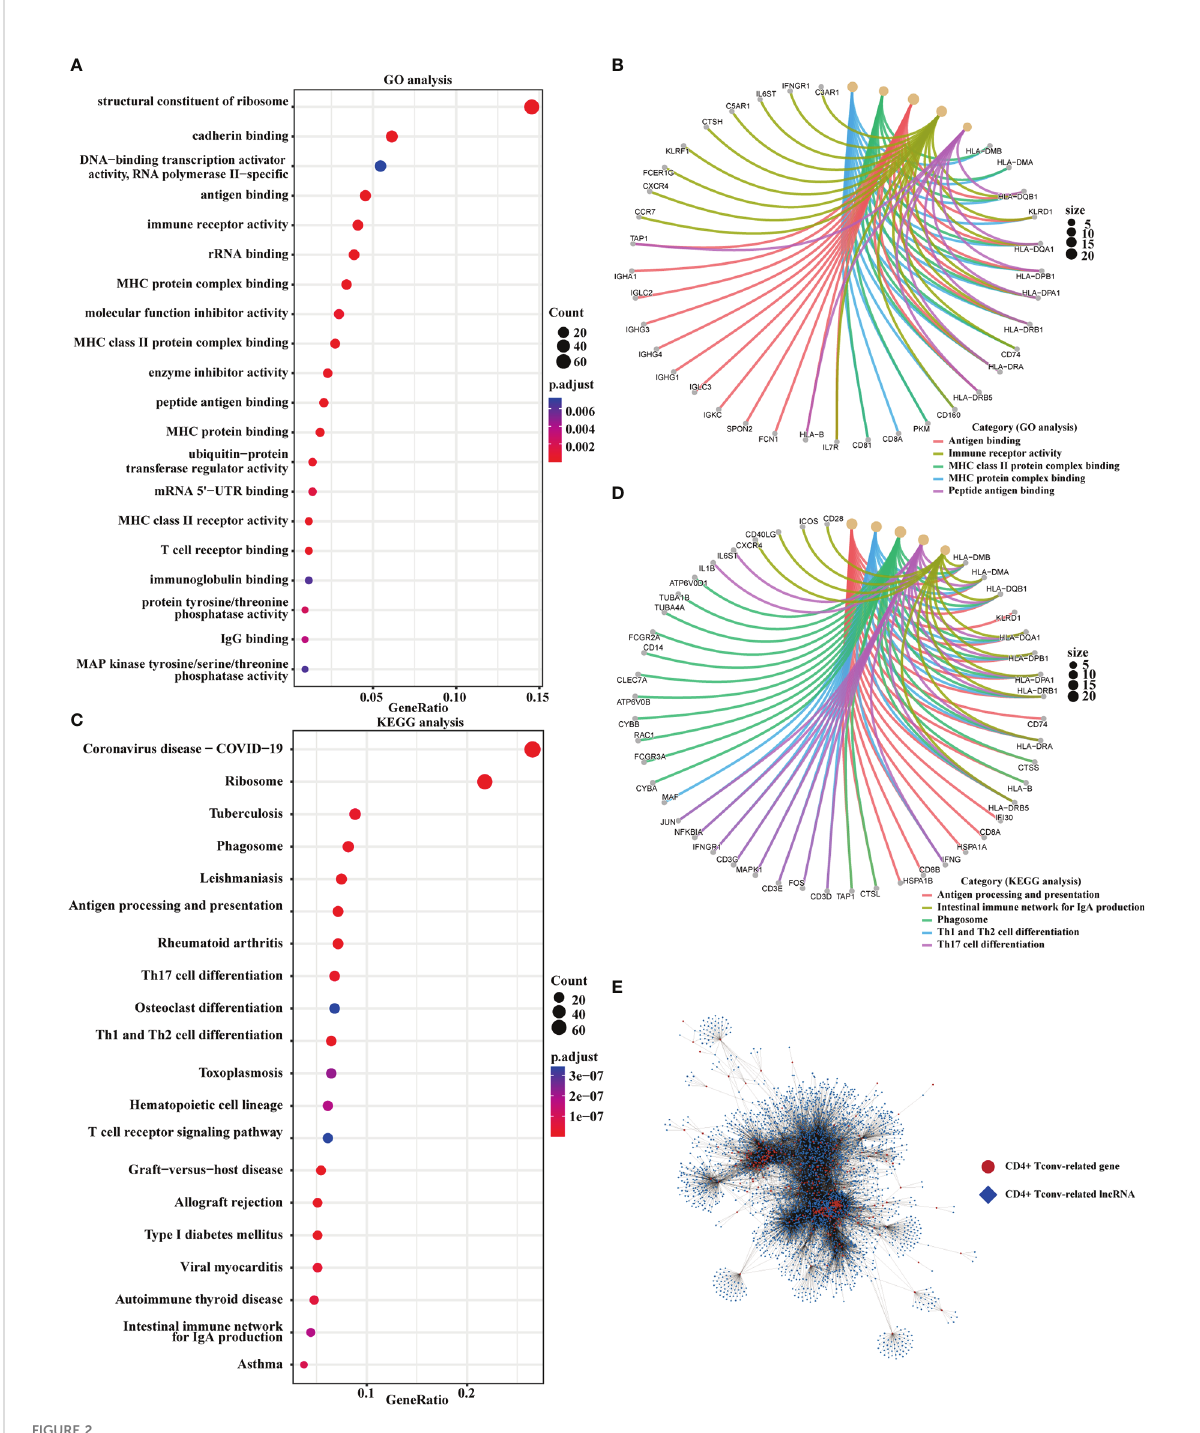
FIGURE 2 Functional enrichment and the co-expression network of CD4+ Tconv-related genes. (A, B) The dot plot and the network graph of GO analysis. (C, D) The dot plot and the network graph of the KEGG pathways analysis. (E) Co-expression network of CD4+ Tconv-related genes and